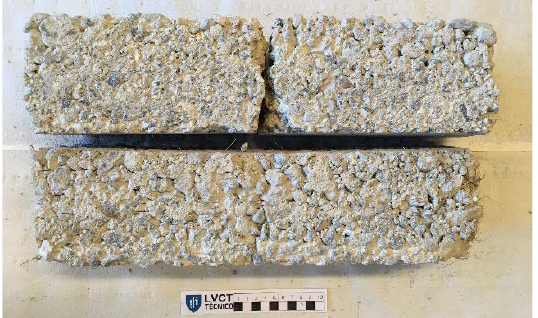
Figure 7. Example of CBGM specimens, without CF (top) and with CF (bottom), after the flexural strength test. strength